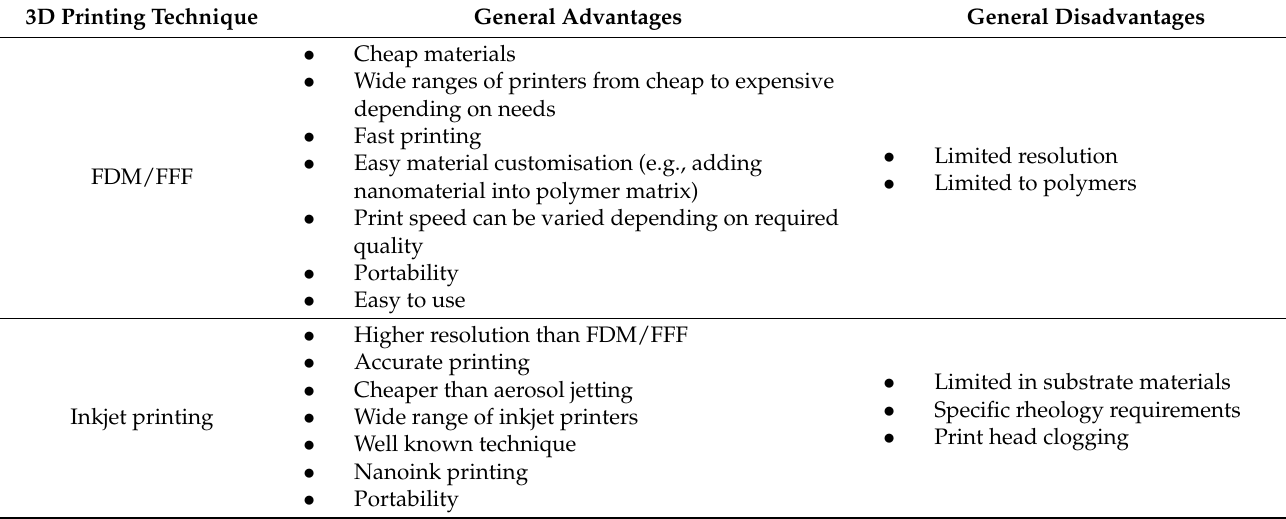
Table 3. General advantages and disadvantages of commonly used 3D printing methods in flexible sensor fabrication. 3D Printing